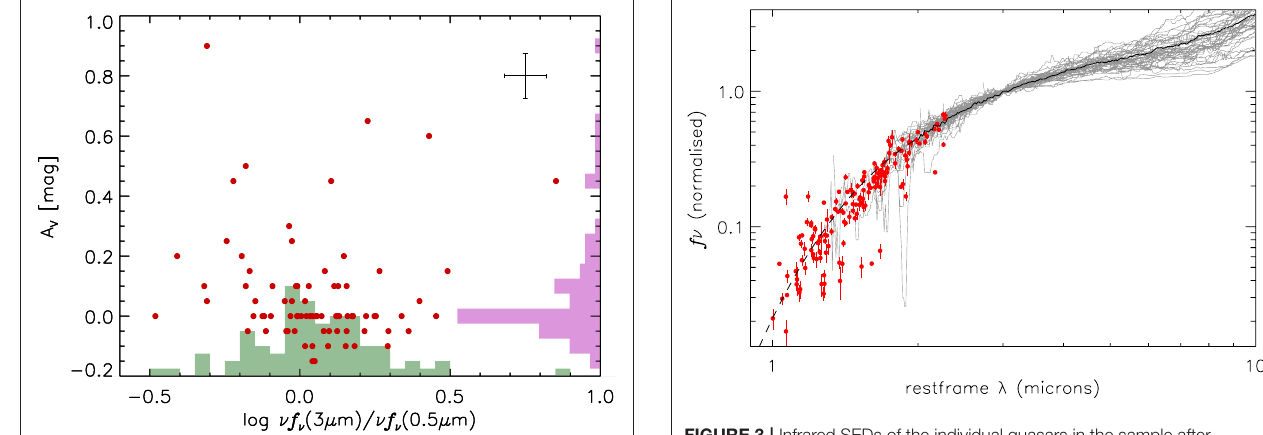
FIGURE 3 | Infrared SEDs of the individual quasars in the sample after subtraction of the disk component. The gray lines represent the (AKARI+)IRS spectrum, while the red dots represent the broadband data points at wavelengths with no spectroscopic coverage. All the individual SEDs are normalized at rest-frame 3 µ m. The solid black line is the composite AKARI+IRS spectrum obtained for the same sample in Hernán-Caballero et al. (2016) . The dashed black line is an extrapolation of this composite using a T = 1,400 K black-body